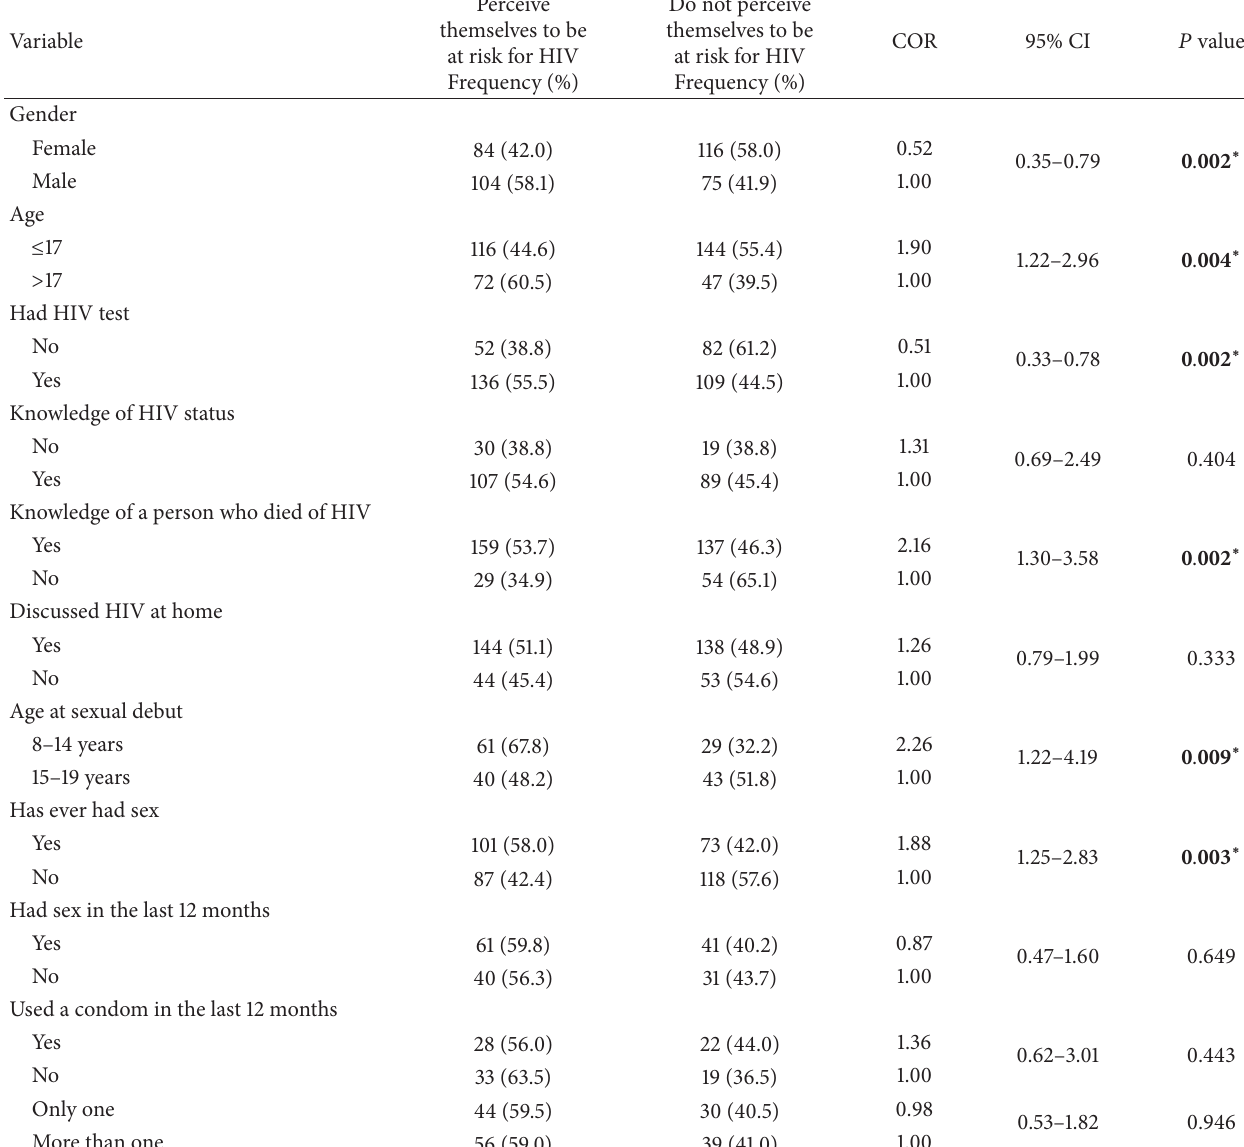
Table 2: Factors associated with perceived risk of contracting